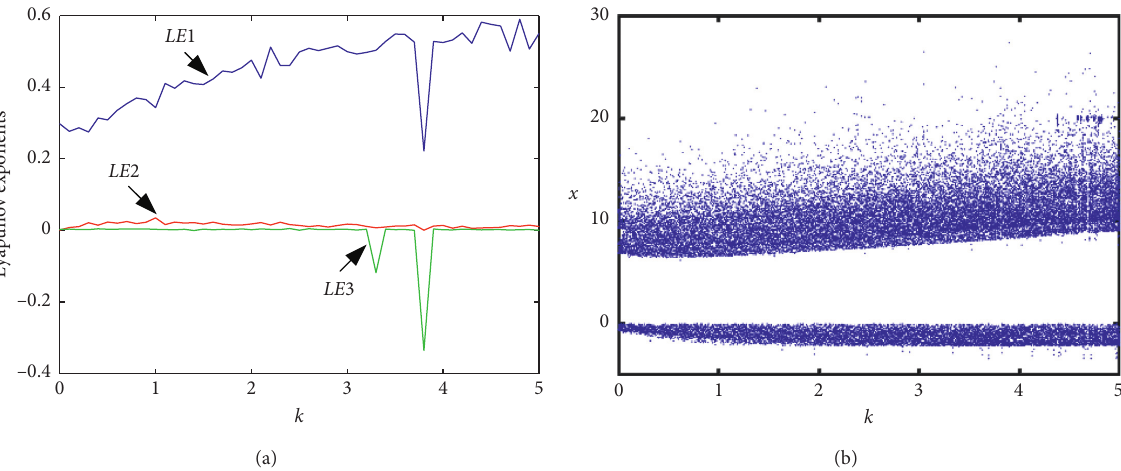
Figure 9: Lyapunov exponent spectra and bifurcation diagram of system (4) with a � 2, b � 3, c � 5, and d � 0.75, while k varies in [0, 5]: (a) Lyapunov exponent spectra: LE 1 is blue, LE 2 is red, and LE 3 is green; (b) bifurcation diagram.